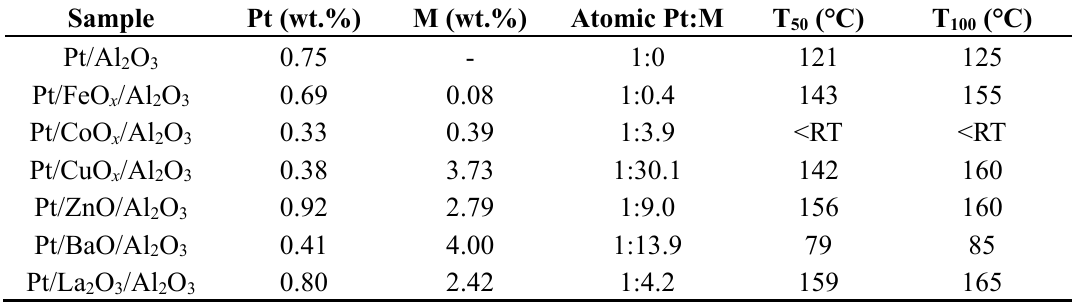
Figure 6. XRD patterns of Pt/MO x /Al 2 O 3 catalysts collected after reaction testing. The XRD pattern of α -Al 2 O 3 support is shown for comparison. (*: Pt). Table 3. ICP results, T 50 , and T 100 for Pt/MO x /Al 2 O 3